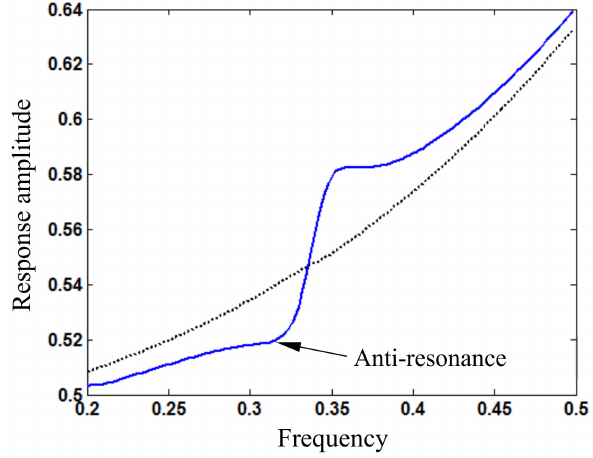
Figure 8. Amplitude ( w Am ) frequency ( ω ) relation around super-harmonic resonance for loading amplitude F s 1 = 0.5 (blue solid line: response based on periodic solution; black dotted line: response based on first harmonic term).